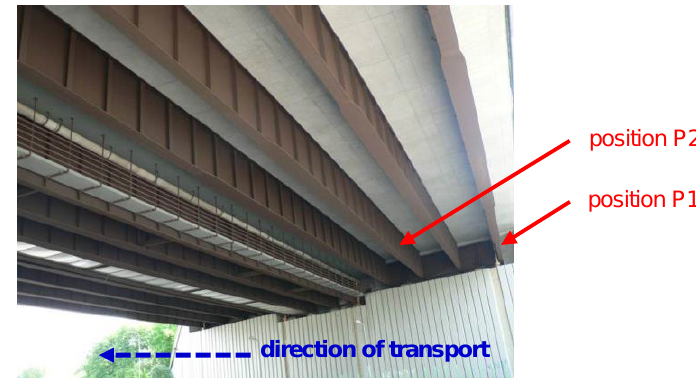
Figure 12. Direction of traffic and positions P1 and P2.